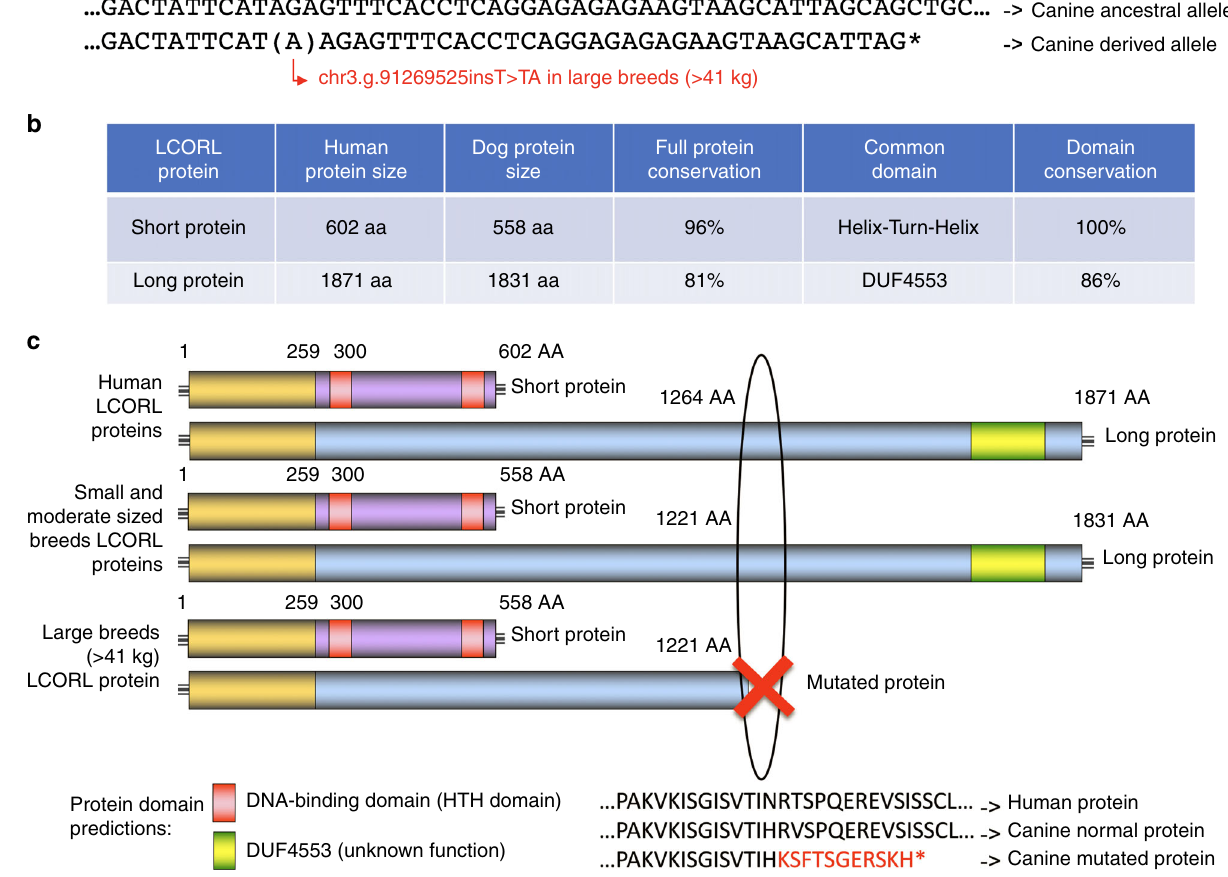
Fig. 2 Identi fi cation of LCORL mutation in large breeds and comparison with human. a Comparison of genomic sequences between human and the two canine alleles. A single nucleotide insertion is observed in large breeds (>41kg). b Conservation of the two main LCORL proteins and their predicted functional domain using SIM 68 and LALNVIEW 69 . c Schematic representations of LCORL proteins, highlighting the effect of the canine mutation (STOP codon after amino acid 1221 leads to a loss of 610 aa). The common part shared by all forms is colored in yellow. Source data are provided as a Source Data fi